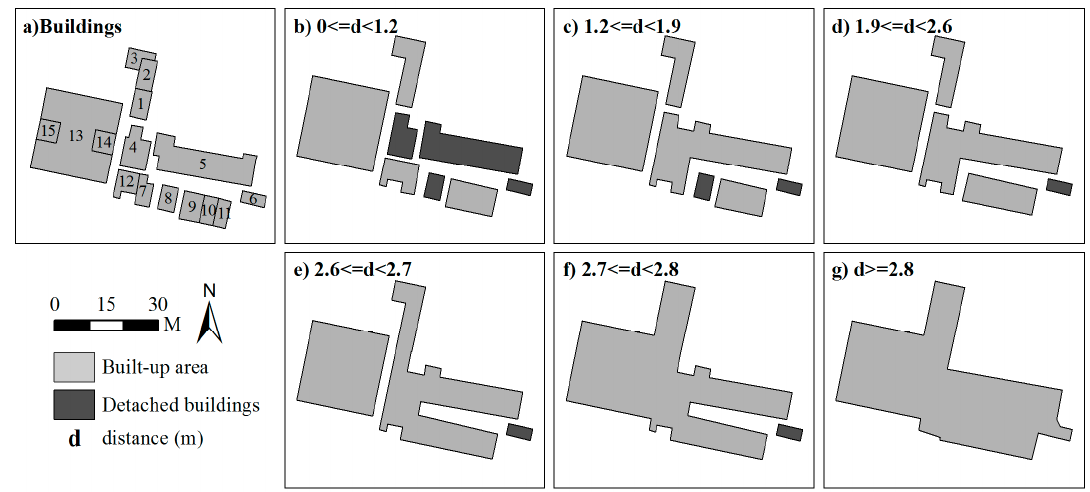
Figure 13. Multi-scale representations of buildings created with the proposed method. The level of detail will not change in a scale interval. The lower limit of a scale interval denotes the moment when a level detail of buildings come into being, whereas the upper limit indicates that the representation of buildings will disappear under this given value. Note that all objects are displayed at the same scale in order to clearly show the effects of the amalgamation process.